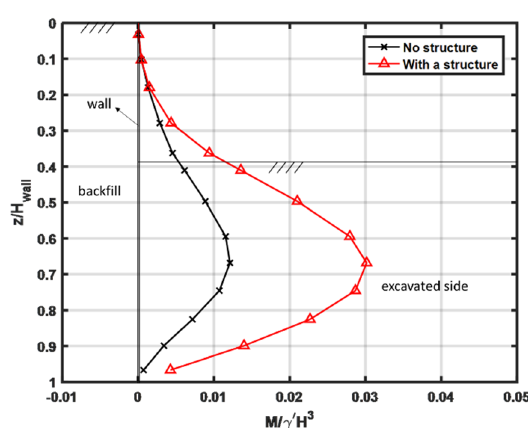
Figure 9. Envelopes of a maximum, normalised dynamic bending moment.